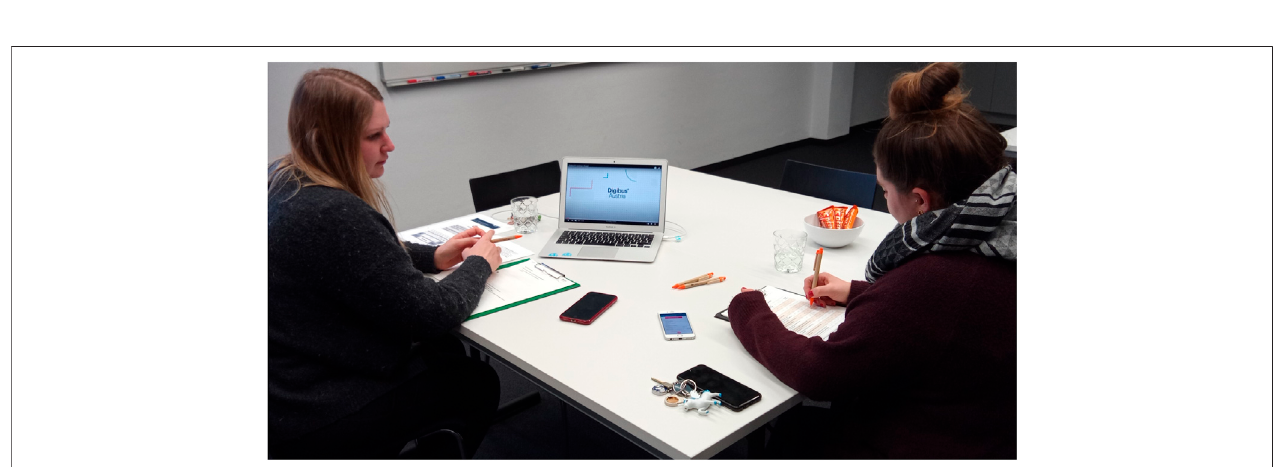
FIGURE 7 | Study 2: Participant interacting with booking app on the right, observer on the left.